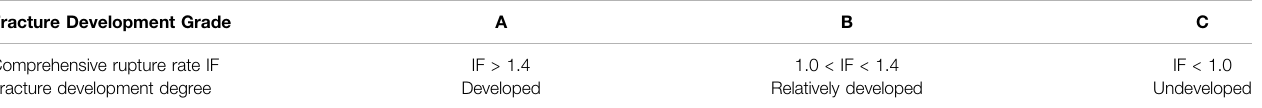
TABLE 1 | Criteria for judging the development degree of Silurian fractures in Shunbei area.